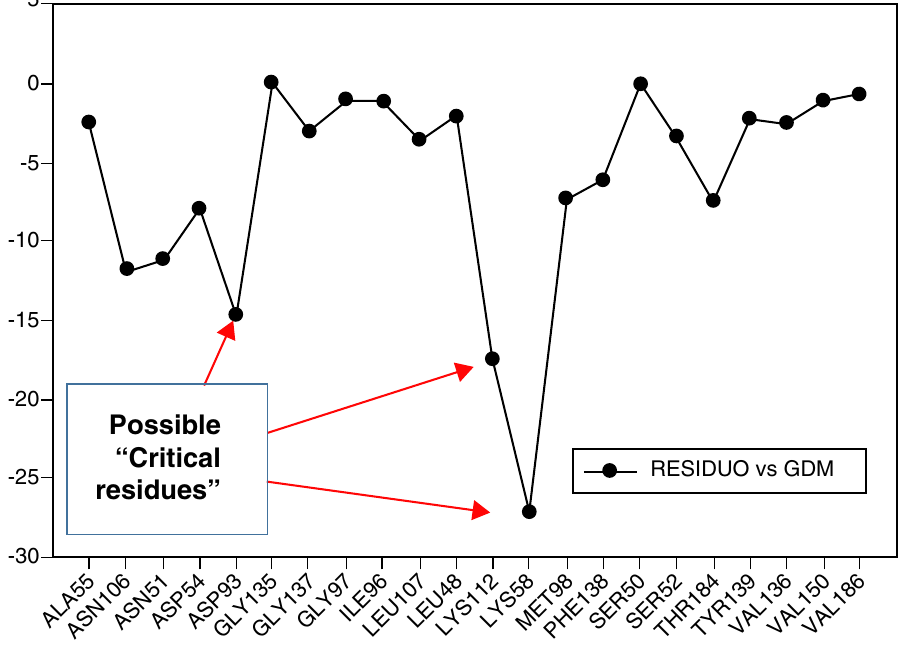
Figure 7. Interaction energies of geldanamycin. Red arrows show the energy interaction values of �ys58, Asp93 and �ys112 residues.Red arrows show the energy interaction values of �ys58, Asp93 and �ys112